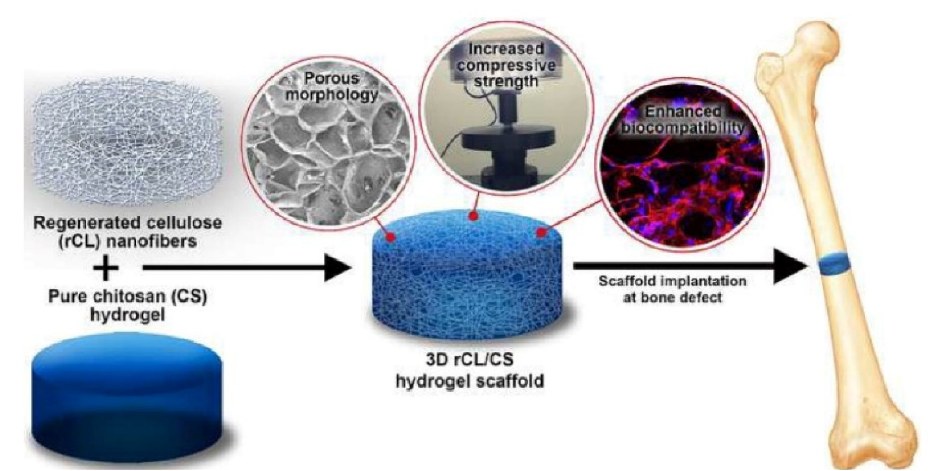
Figure 7 . Hydrogel in bone tissue engineering [219]. Figure 7. Hydrogel in bone tissue engineering